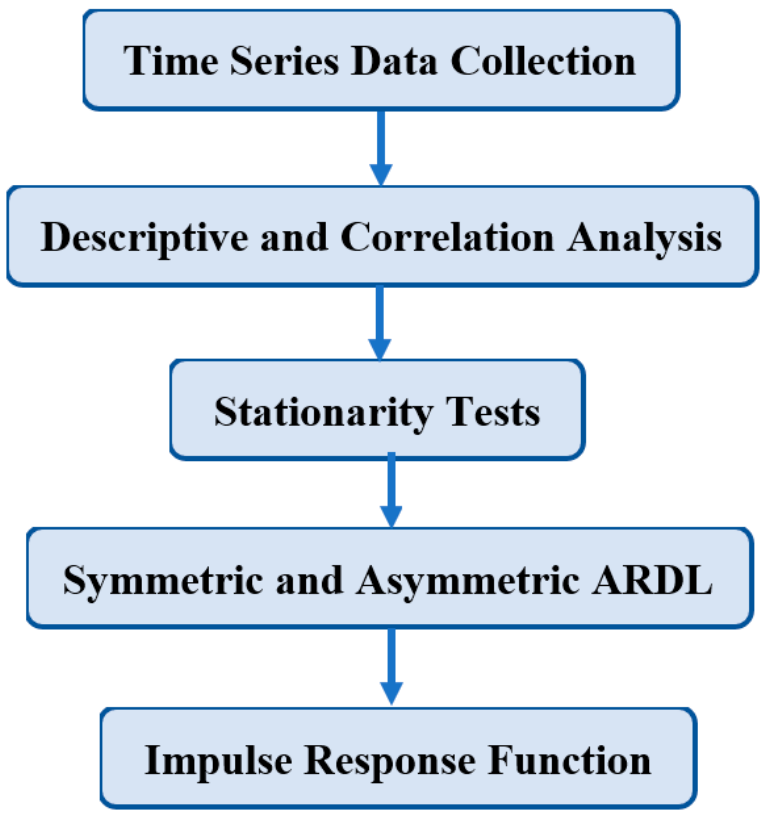
Figure 1. The flow path of methodology.